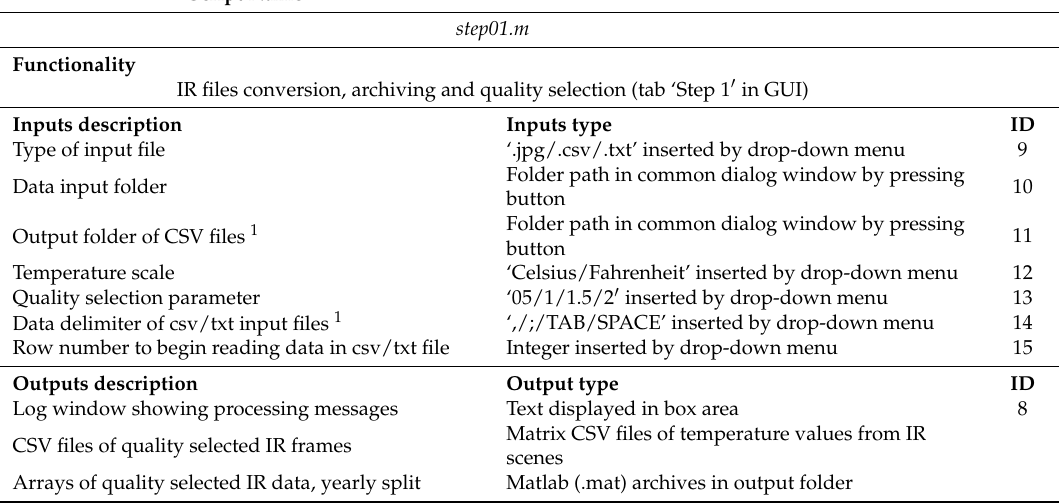
Table A2. Technical specifications of functionality and input/output data type of STEP